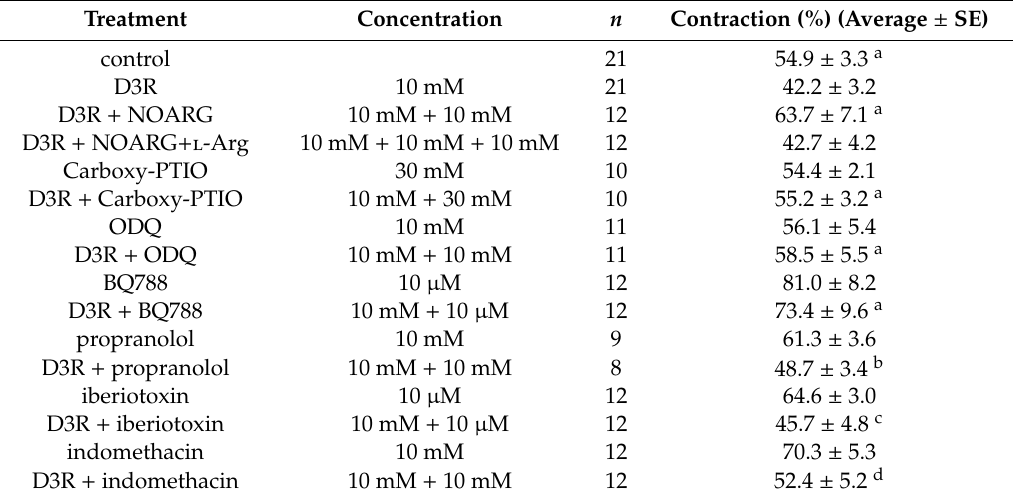
Table 3. Comparison of contraction of the ciliary muscle by ET-1 (10 nM) after treatment with various